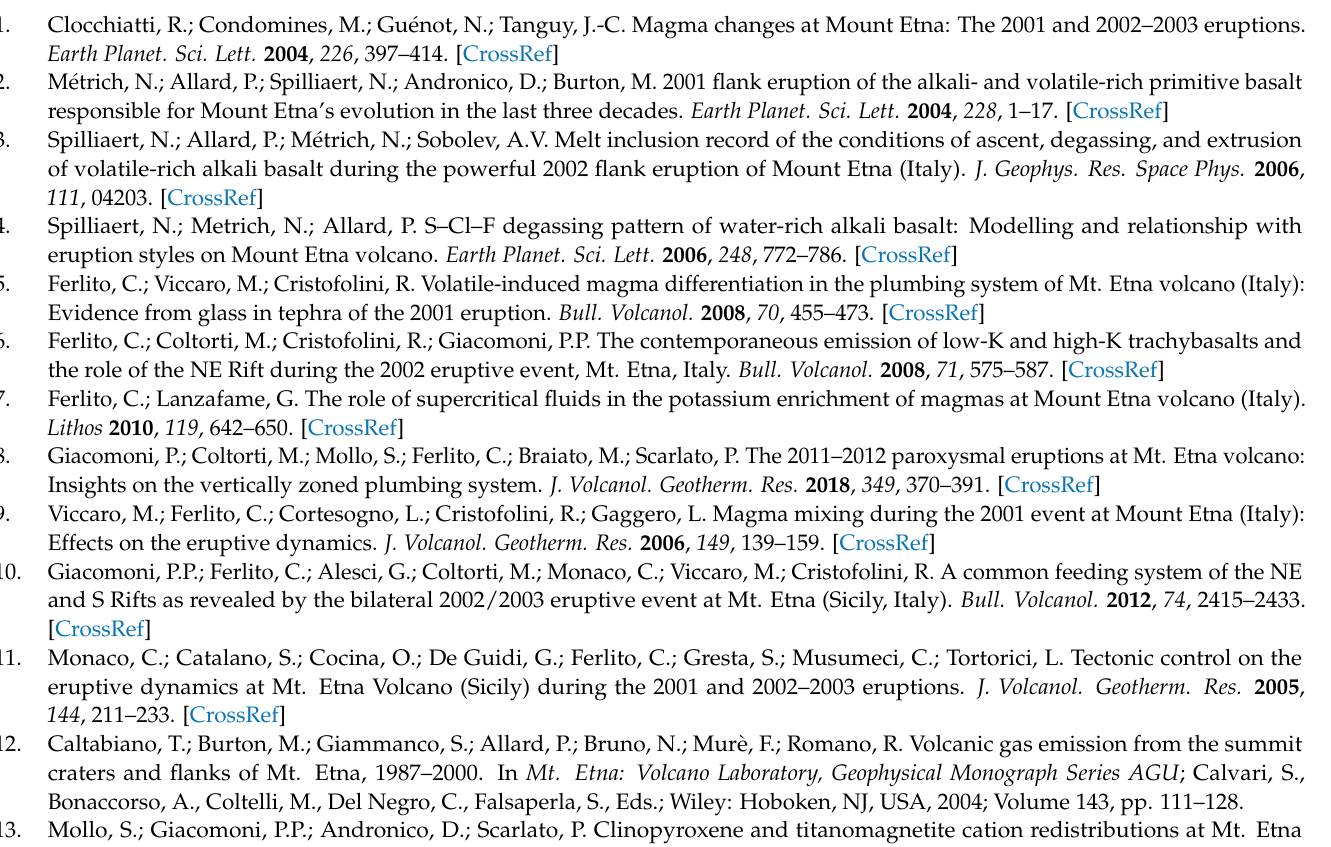
S3: Kd used for fractional crystallization, Table S4: Results of partial melting, Table S5: Kd used for partial